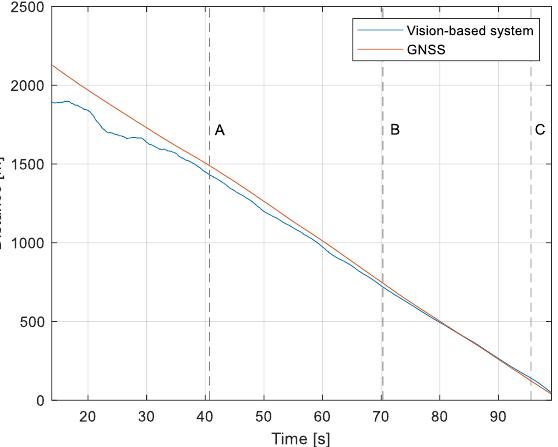
Figure 15. Distance from the runway: Flight no. 1 (markers A – C correspond to the moment of recording the images in Figure 9).